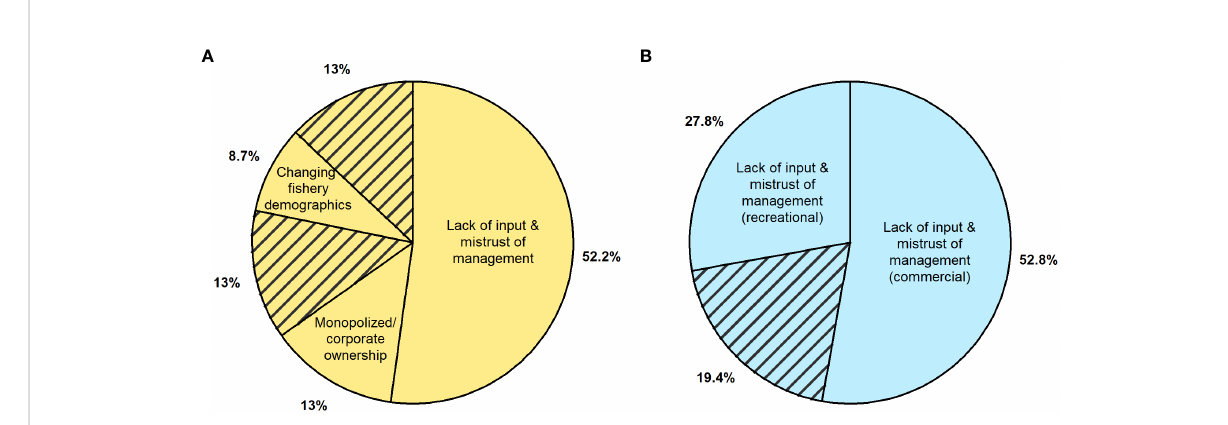
FIGURE 6 Themes from open-ended responses from fi shermen who chose to elaborate on broader concerns with fi shery governance and its effects on adaptive capacity. (A) indicates the percent of responses from market squid fi shermen who chose to elaborate (n=23) and (B) indicates the percent of responses from spiny lobster fi shermen who chose to elaborate (n=37). Each theme is labeled in the pie chart and hashing indicates overlap between two adjacent